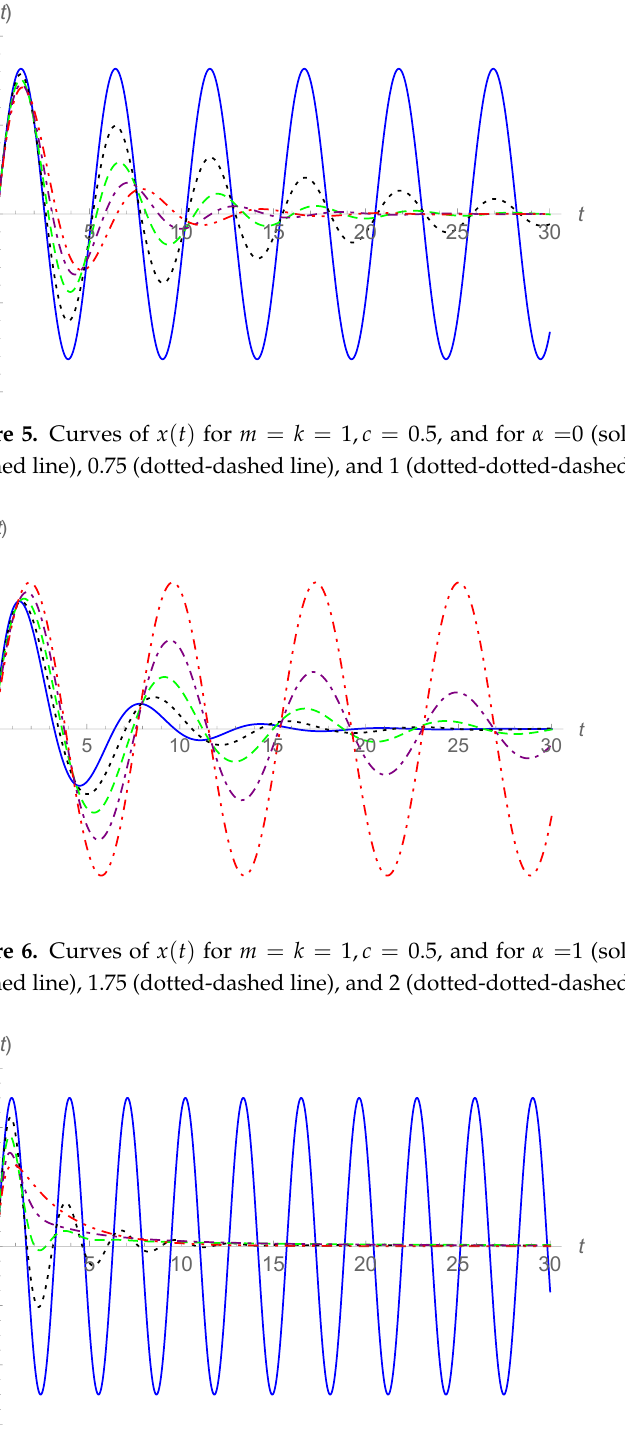
Figure 7. Curves of x ( t ) for m = k = 1, c = 3, and for α = 0 (solid line), 0.25 (dotted line), 0.5 (dashed line), 0.75 (dotted-dashed line), and 1 (dotted-dotted-dashed